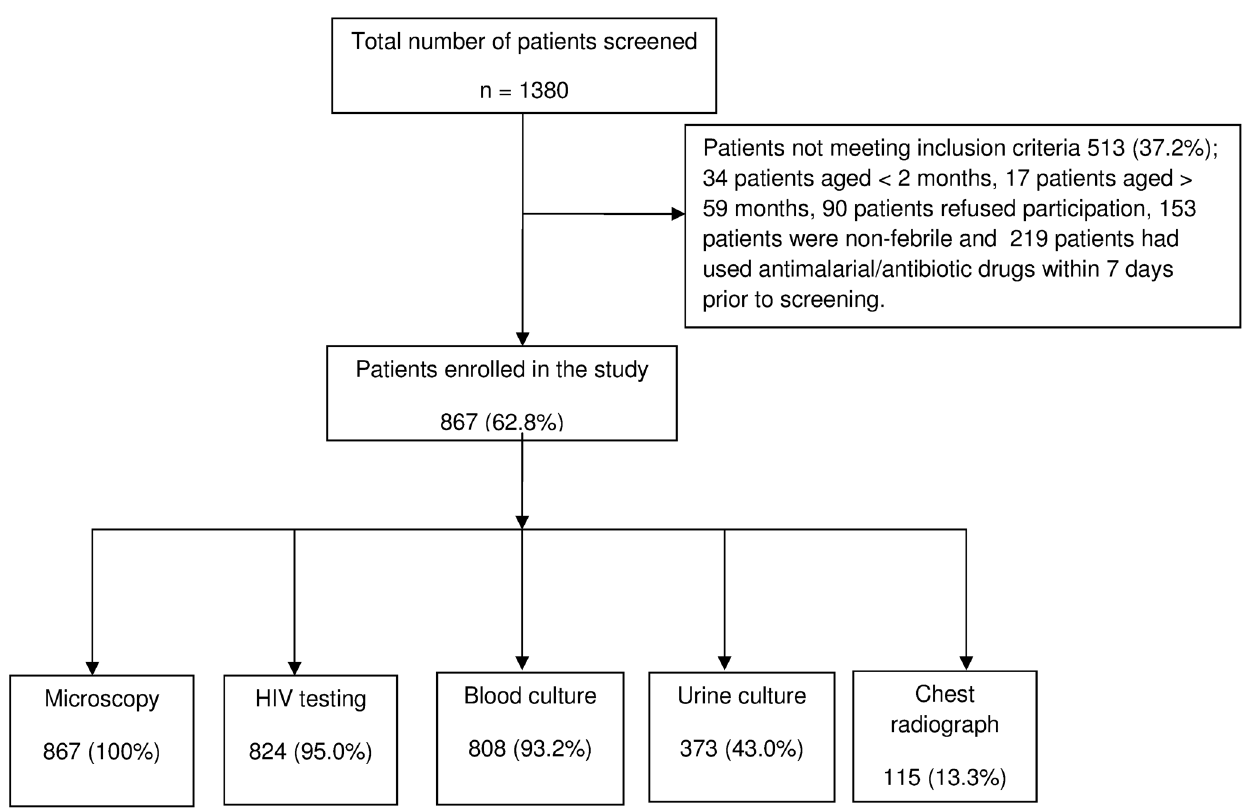
Figure 1. Study flow diagram of patient enrollment at KDH and the investigations performed.